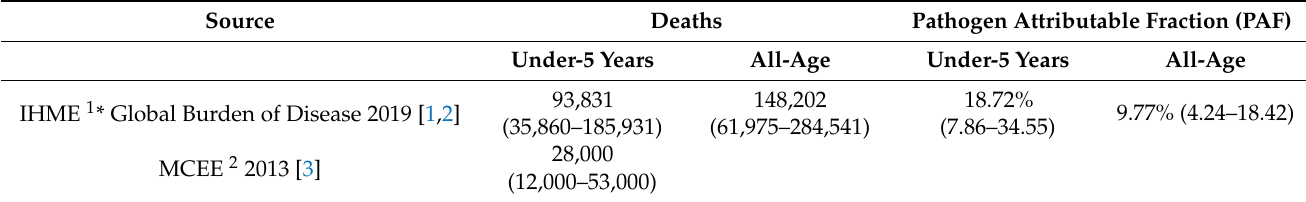
Table 1. Estimated deaths and pathogen attributable fraction of diarrheal deaths due to Shigella for all ages and for children under-5